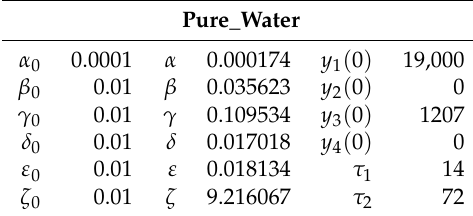
Figure 2. Fitting to “Ten-nensui” data. Table 2. Various parameter